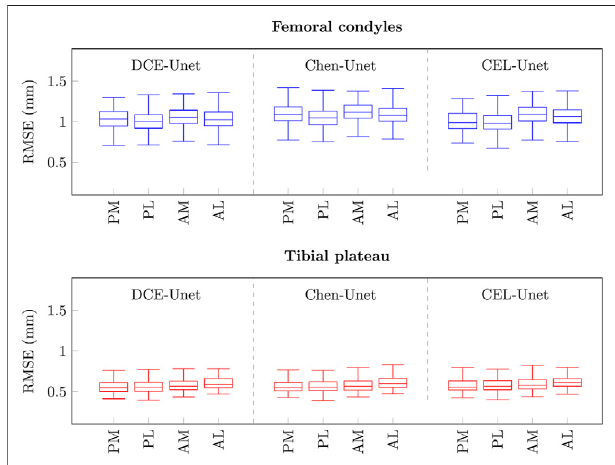
FIGURE 11 | Boxplots of local RMS errors (mm) at femoral condyle (blue), and tibial plateau (red) areas. P: posterior, A: anterior, M: medial, L: lateral. Table 7 ). Segmentation analysis at femoral condyles and tibial plateau con fi rmed 3D errors compatible with accurate matching of the resection mask with the true anatomy.